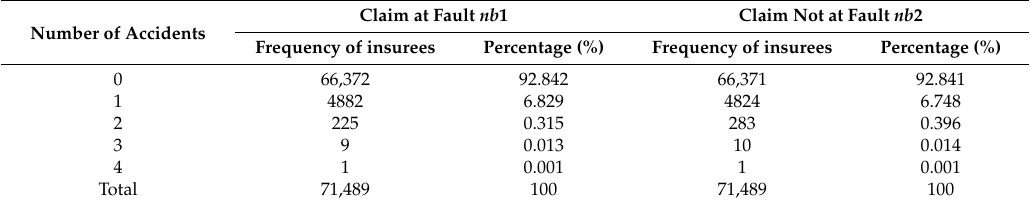
Table 3. Absolute and relative frequencies of claims where there are property